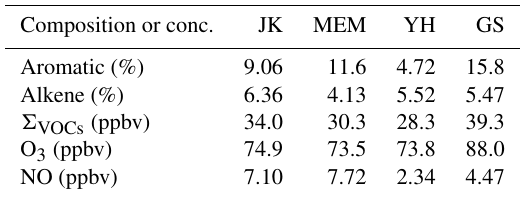
Table 4. Specific information on VOCs, O 3 and NO at the four sites in June